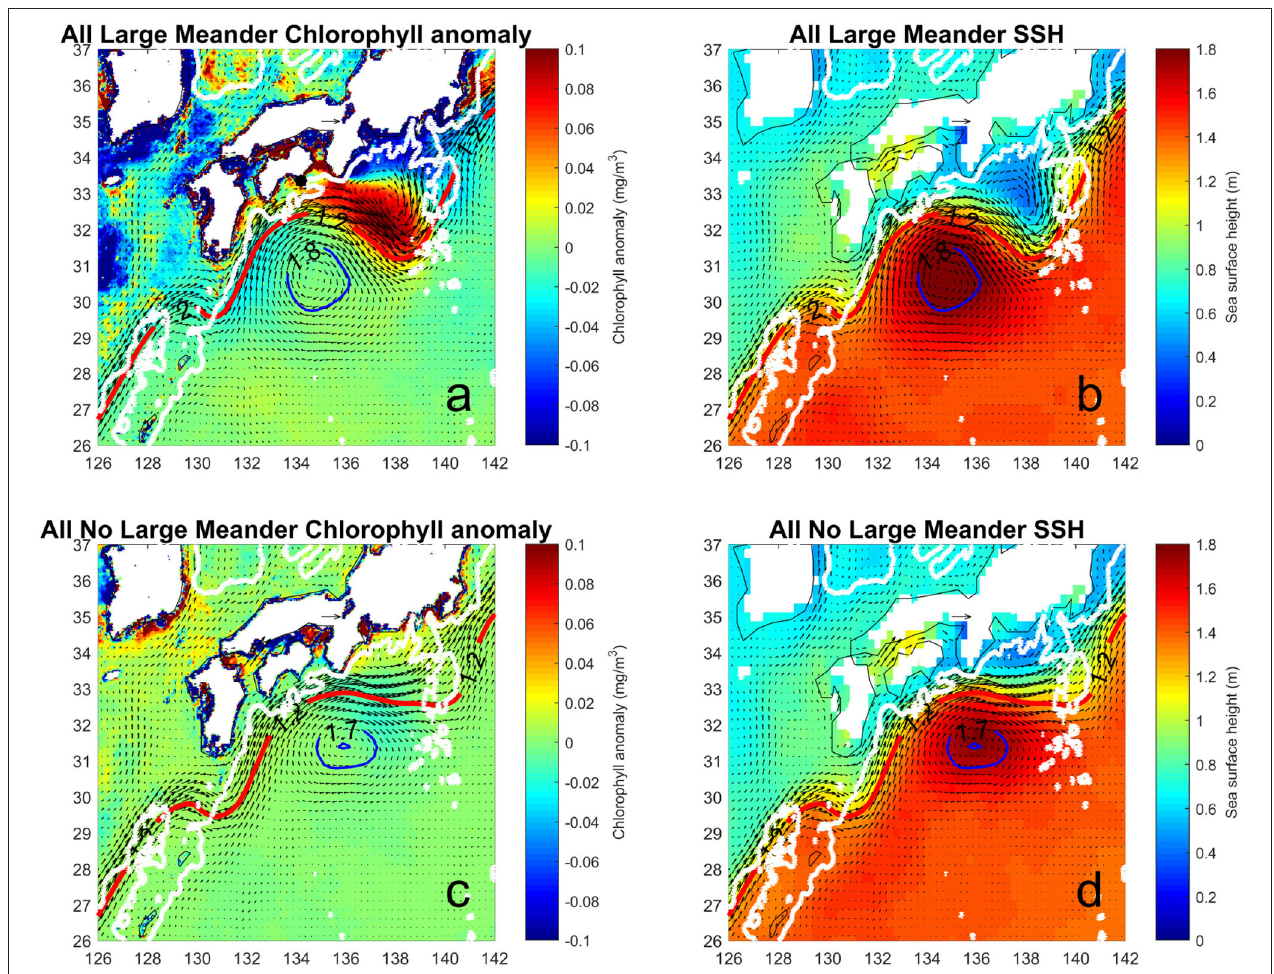
FIGURE 2 | Chlorophyll anomaly and sea surface height (SSH) or absolute dynamic topography during the Large Meander (a,b) and No Large Meander (c,d) . Geostrophic flow is represented with arrows and a recirculation gyre is illustrated with the blue SSH contours. The red curves represents the Kuroshio axis defined by the SSH contour at 1.2